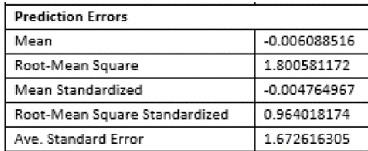
Table 6: Values of the Prediction Errors of the Best Surface for